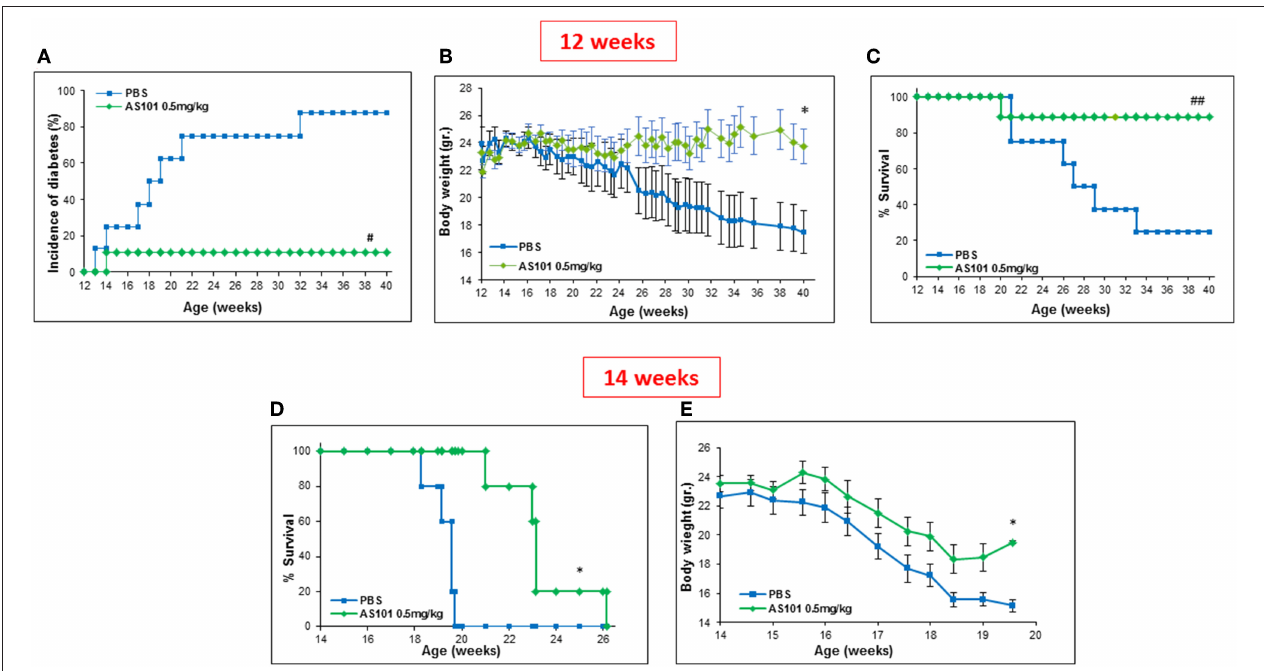
FIGURE 6 | Treatment with AS101 starting at 12 weeks of age prevents the development of T1D in NOD mice. PBS or AS101 at 0.5 mg/kg/injection was administered i.p. every other day at different doses to female NOD mice, starting at 12 weeks of age, until 40 weeks. The incidence of diabetes (A) , body weight (B) , and percent survival (C) were monitored, n = 10/group. (D,E) AS101 at 0.5 mg/kg/injection was administered i.p. every other day at different doses to female NOD mice, starting at 14 weeks of age. Survival (D) and body weight (E) of mice was monitored. n = 5 mice/group. ## p < 0.005 increase vs. PBS. # p < 0.01 decrease vs. PBS; * p < 0.05 increase vs. PBS.